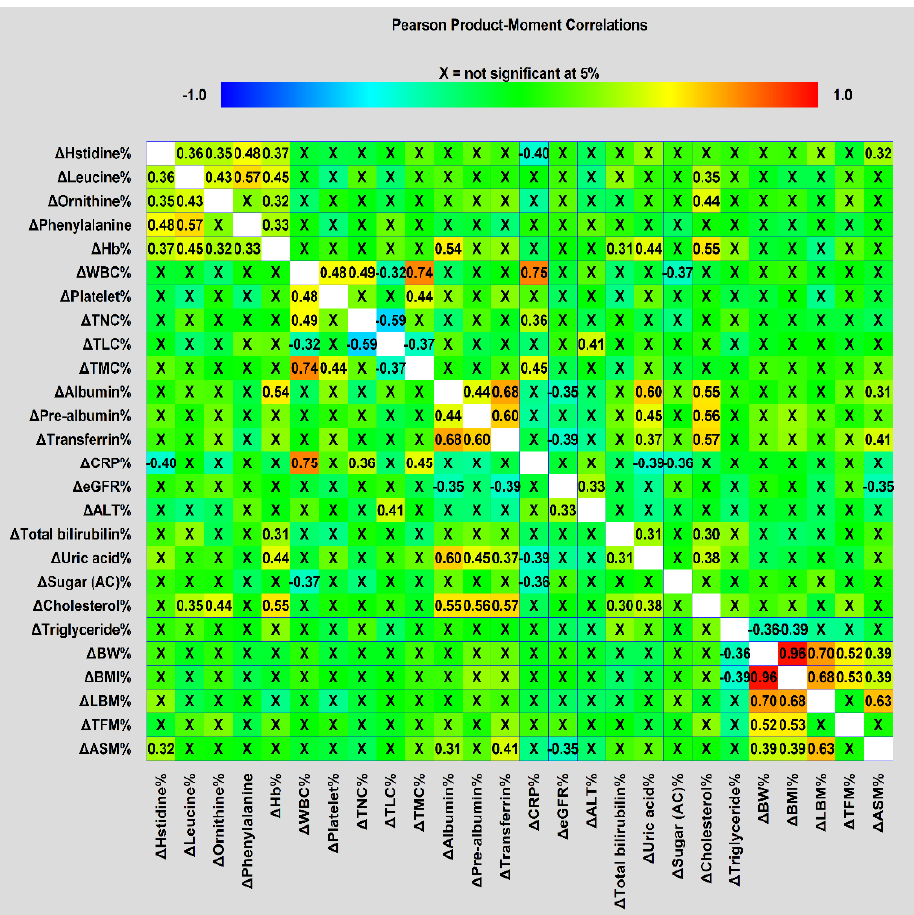
Figure 2. Correlation matrices used to visualize correlations in treatment-interval changes among metabolites, biochemical and anthropometric factors, NIBs, and DXA-derived parameters were obtained using Pearson’s correlation coefficient.